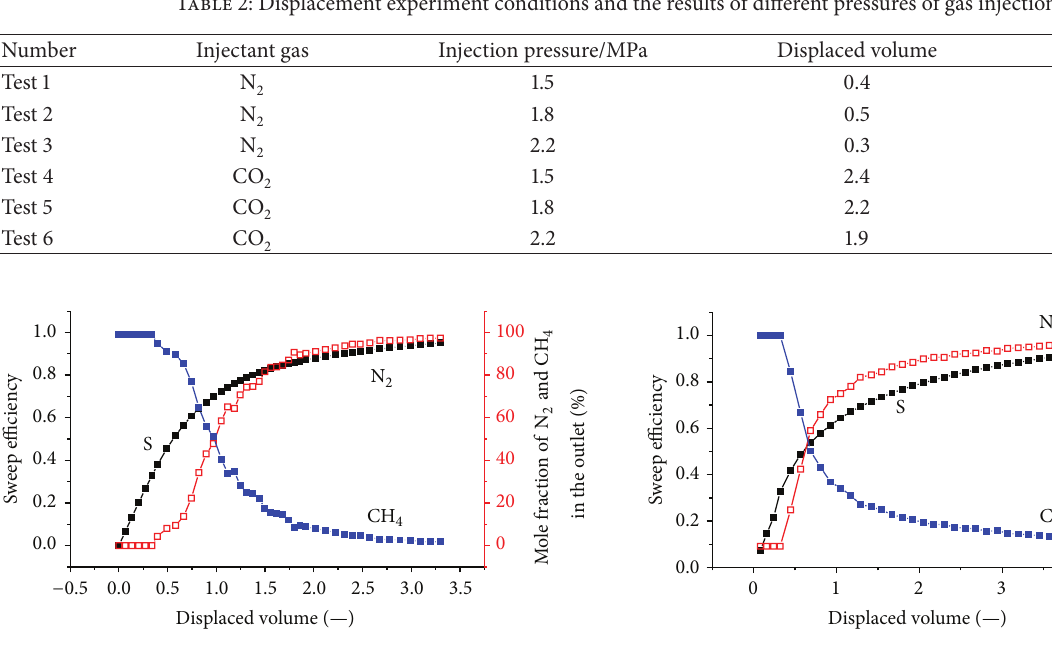
Figure 5: The sweep efficiency and concentrations of produced gas against displaced volume at 1.5 MPa.